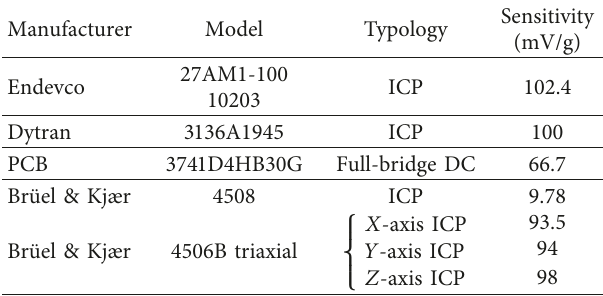
Table 1: Accelerometers employed.